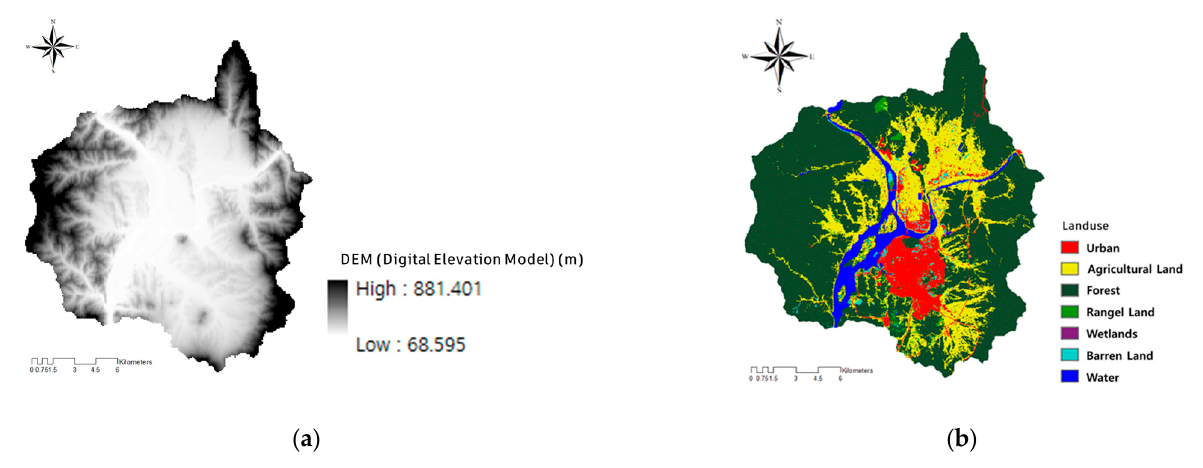
Figure 4. Input data for the HSPF of the Uiam watershed (DEM provided by the National Geographic Information Institute and 2017 land cover map provided by the Environmental Geospatial Information Service). (( a ) DEM ( b ) Land use). Table 1. Data necessary for HSPF modeling.